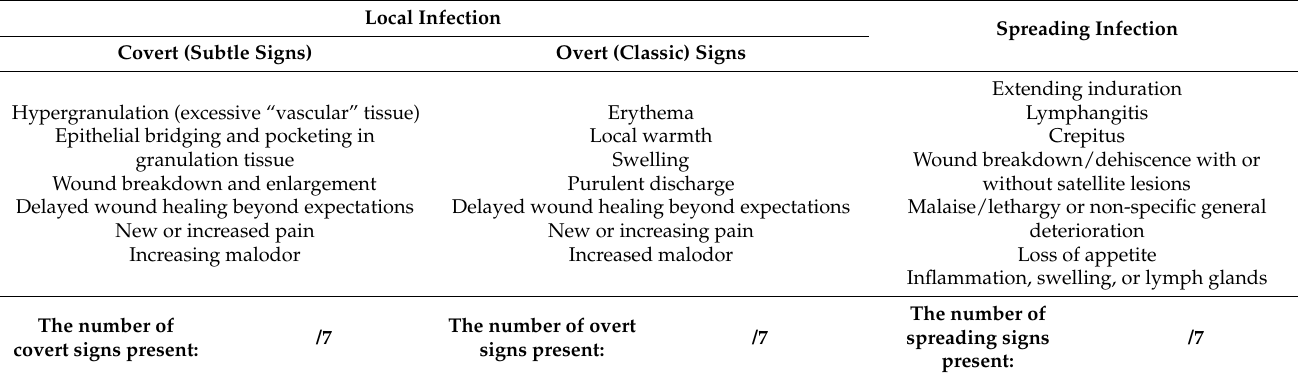
Spreading Infection